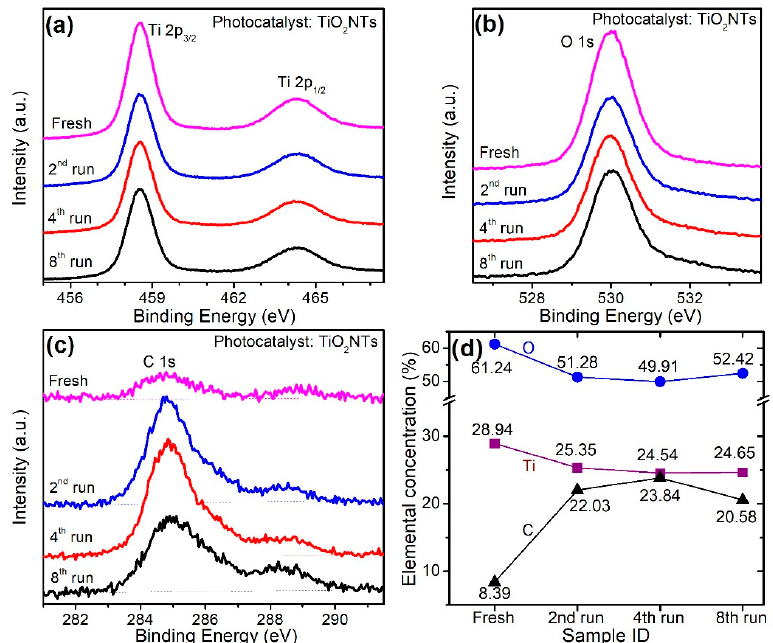
Figure 7. Fine-scan XPS spectra of ( a )Ti 2p, ( b ) O 1s and ( c ) C 1s taken from recycled TiO 2 NTs photocatalysts. ( d ) Ti, O, and C atomic concentrations determined by XPS for recycled TiO 2 NTs catalyst (up to 8th run).